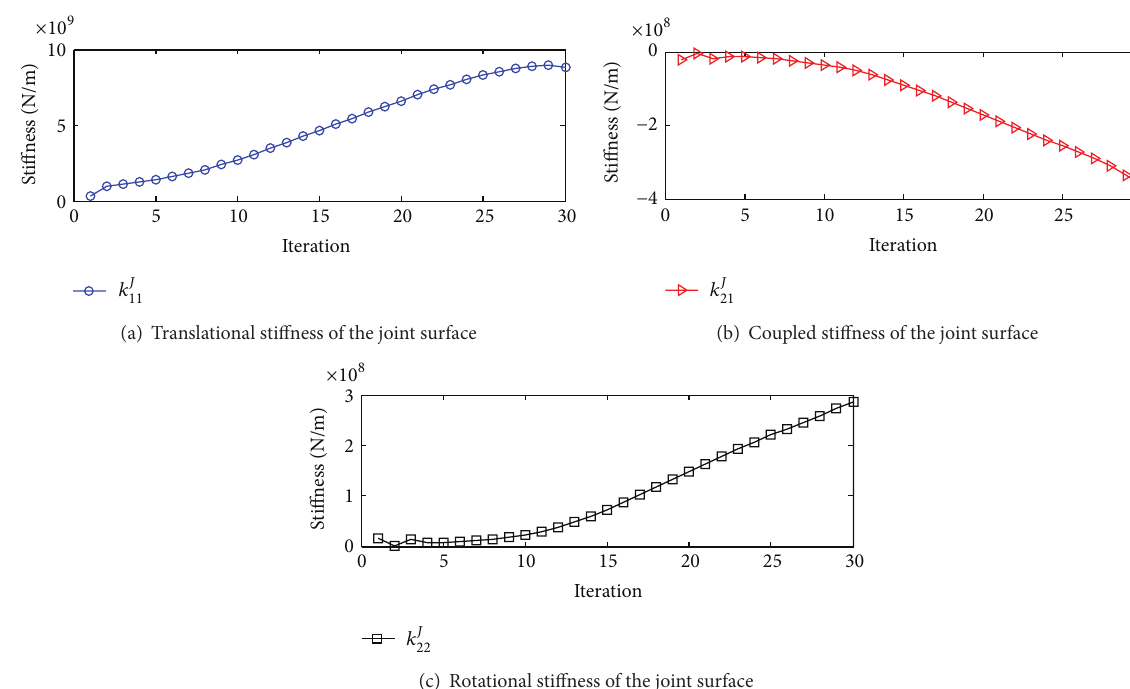
Figure 5: Iterative procedure of the updated